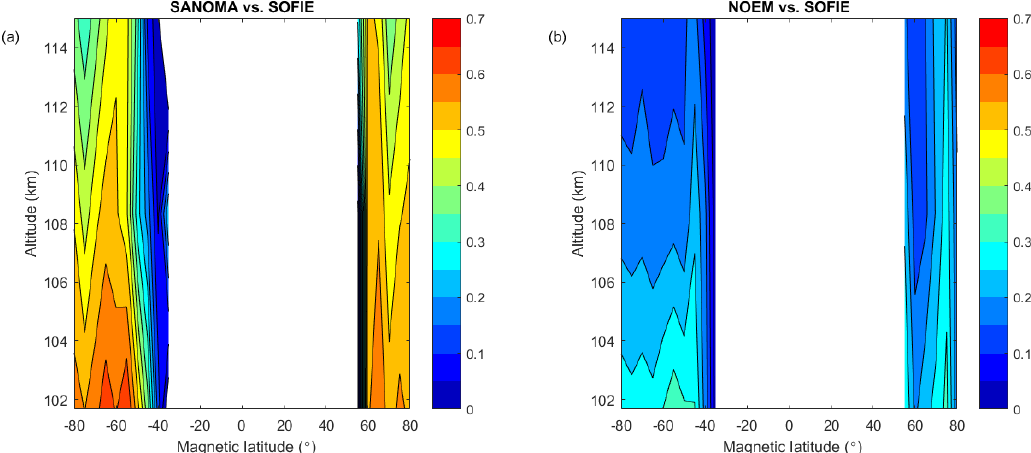
Figure 15. (a) Adjusted R 2 of linear fits between SANOMA and SOFIE NO number density. (b) Adjusted R 2 of linear fits between NOEM and SOFIE NO number density.